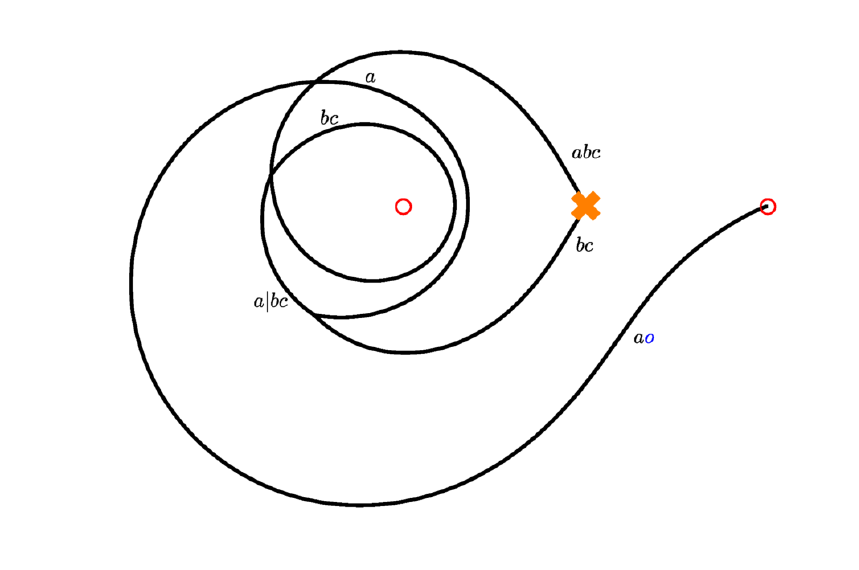
Figure 56. D4 + 3D0, one (+ (cid:0) ) 1 street corresponding to the partition (2,1).